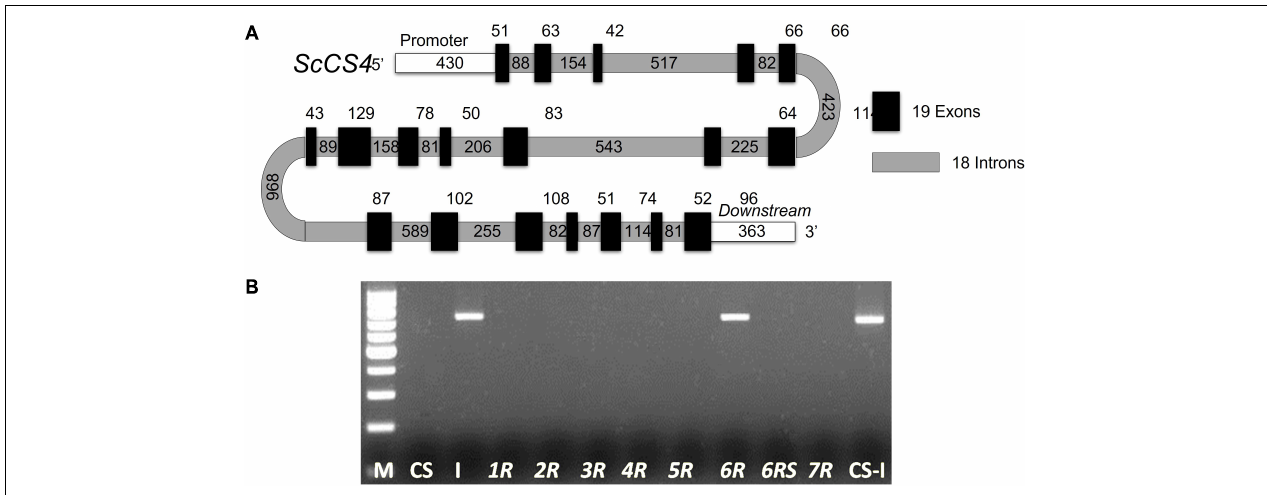
FIGURE 1 | (A) Schematic representation of the ScCS4 gene. This gene has 19 exons and 18 introns. The exons are depicted as black boxes, and the introns are depicted as gray boxes. The numbers indicate their respective sizes in bp. A 430-bp fragment corresponding to the upstream (promoter) region and a 363-bp fragment corresponding to the downstream region were isolated. (B) Chromosomal location of the ScCS4 gene. CS: Chinese Spring ( T. aestivum ). I: Imperial ( S. cereale ). CS-I : Wheat–rye amphiploid. 1R , 2R , 3R , 4R , 5R , 6R , and 7R : Wheat-rye disomic addition lines (Chinese Spring–Imperial). 6R S : rye chromosome arm 6R S ditelosomic addition line. M : molecular